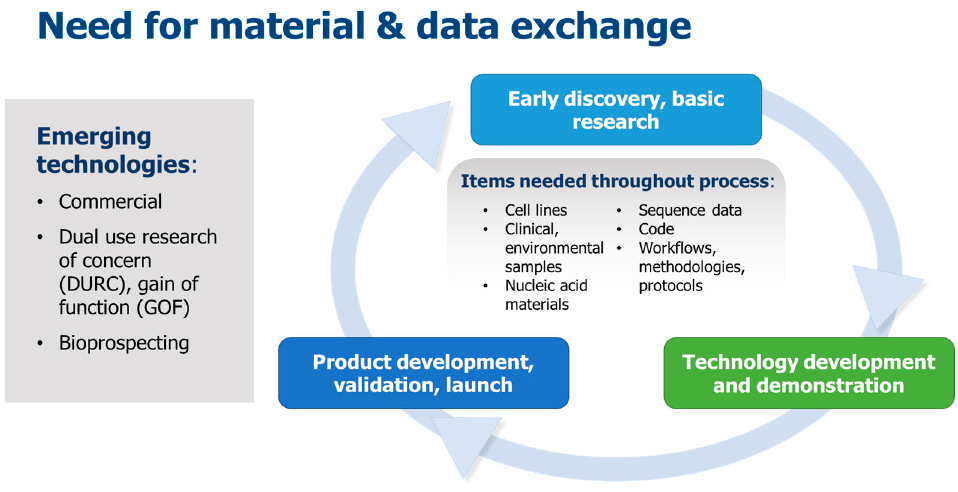
Figure 1. Typical biotechnology research and development process. Material and data exchange is required especially for emerging